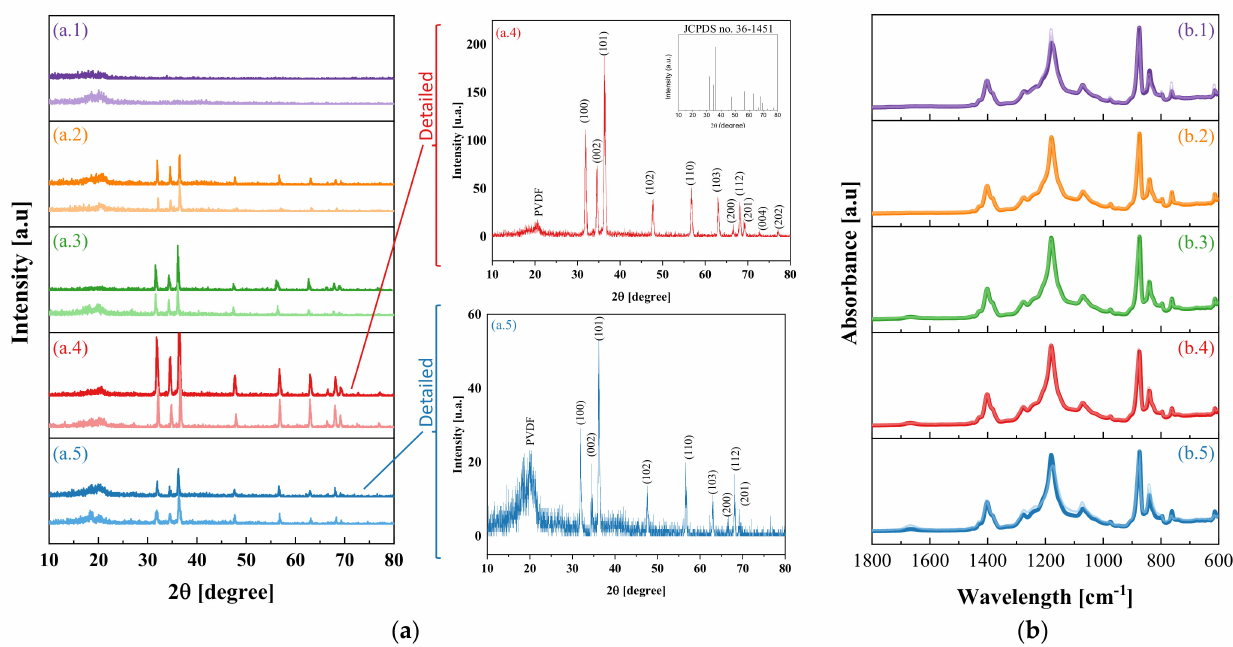
Figure 3. XRD ( a ) and FTIR-ATR ( b ) of samples (1) P-1, (2) PZ-1, (3) PVZ-1, (4) PVZ-4, and (5) PAZ-1, before (darker line) and after (lighter line) n -decane photocatalytic oxidation.